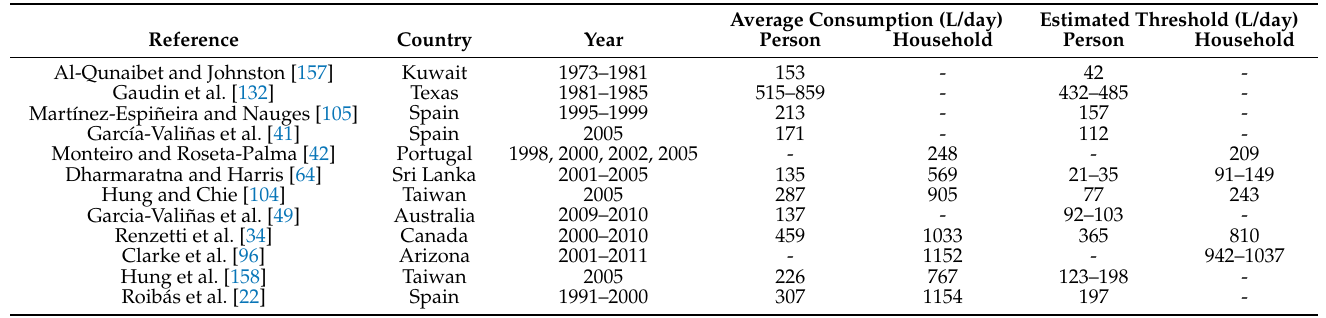
Table 2. Demand function based on a Stone–Geary utility function: Estimated threshold. Average Consumption (L/day) Estimated Threshold (L/day) Reference Country Year Person